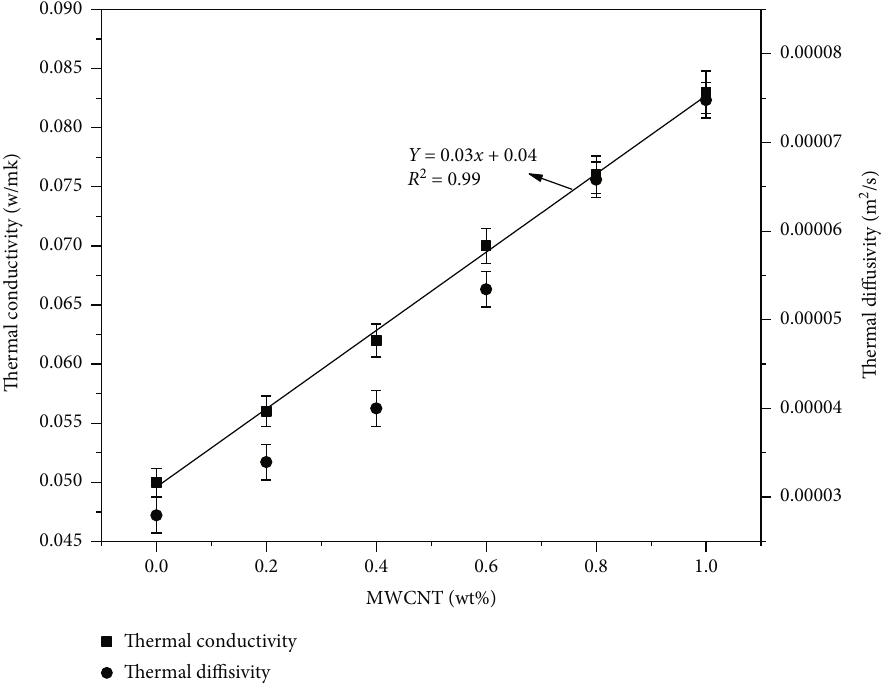
Figure 11: MWCNT-reinforced composite ’ s thermal di ff usivity and thermal conductivity. Table 1: Thermal